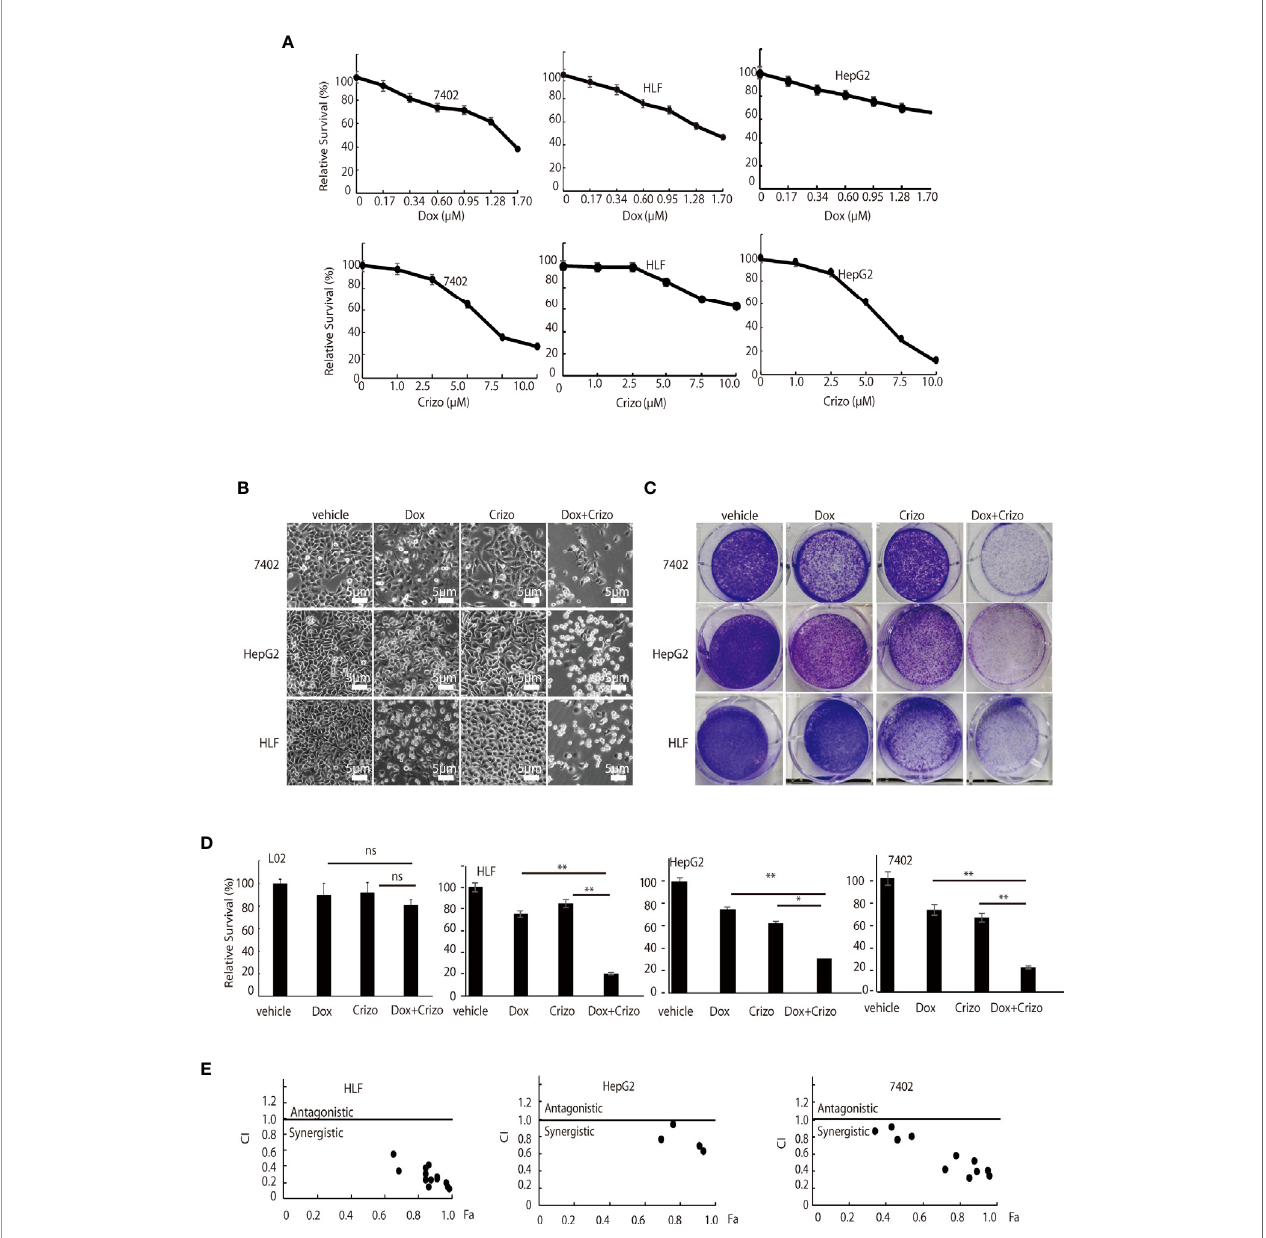
FIGURE 1 | Dox and Crizo treatment synergistically induces hepatocellular carcinoma cell death. (A) HFL was relatively resistant to Crizo based on MTS assays under the tested conditions. Cells were treated with different concentrations of Dox or Crizo for 24 hs and quanti fi ed by MTS. Number of cells with vehicle treatment was arbitrarily de fi ned as 100%, percentage of survival was the ratio of number of cells treated with Dox or Crizo to number of cells with vehicle treatment under the same condition. (B) Relative survival of 7402, HepG2, and HLF cells was monitored by bright fi eld observation at 24 hours after the cells were treated with Dox (0.5 m M), or Crizo (5 m M), or Dox (0.5 m M) plus Crizo (5 m M). The number of cells at the time 0 of drug treatment was arbitrarily de fi ned as 1. Scale bar:5 m m. Relative cell survival was the number of cells at indicated time treated with indicated drugs normalized to the number of cells at the time 0 of drug treatment. (C) Clonal formation of different HCC cells showed that signi fi cantly fewer cells survived Dox plus Crizo treatment. Cells were treated with vehicle, Dox, Crizo, or Dox plus Crizo as indicated. (D) MTS Quanti fi cation of four different experiments with L02, HLF, HepG2, and 7402 showed that compared to Dox or Crizo treatment separately, Crizo plus Dox induced signi fi cantly more cells death in cancer cells but not in L02. HCC cells were treated with vehicle, Dox (0.5 m M), Crizo (5 m M), or Crizo (5 m M) plus Dox (0.5 m M) for 24 hours and survived cells were monitored by MTS assays. Percentage cell survival was calculated as in 1 (A) . (E) To calculate combination index (CI) (CompuSyn software), combinations of different concentrations of Crizo, Dox, or Crizo plus Dox were applied to treat HCC cells for 48 hs and cell survival was monitored by MTS, it turned out that Crizo plus Dox showed synergistic effects in killing HCC cells under some combinations of Dox and Crizo even for HLF and HepG2 cells. Fa: fractions of the system affected. The experiments were repeated at least three times with similar results. *P < 0.05; **P < 0.01. ns, statistically no signi fi cant